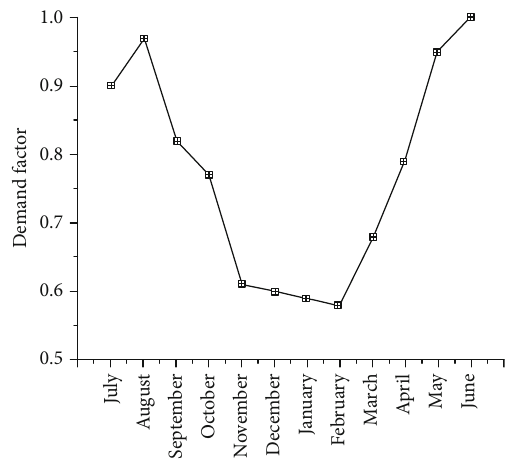
Figure 4: Year-wise demand factor of load in Pakistan.